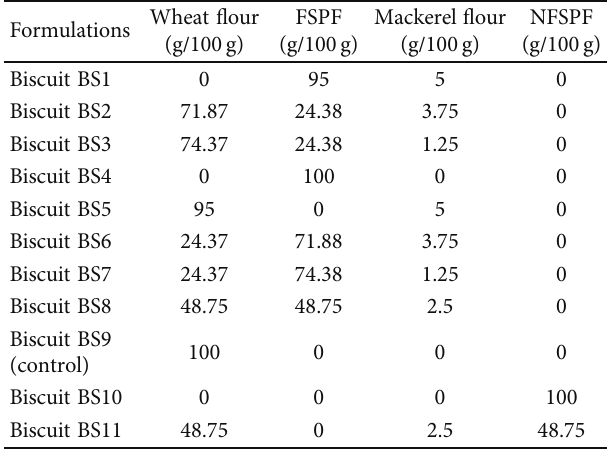
Table 1: Di ff erent formulations of fl ours used for biscuits